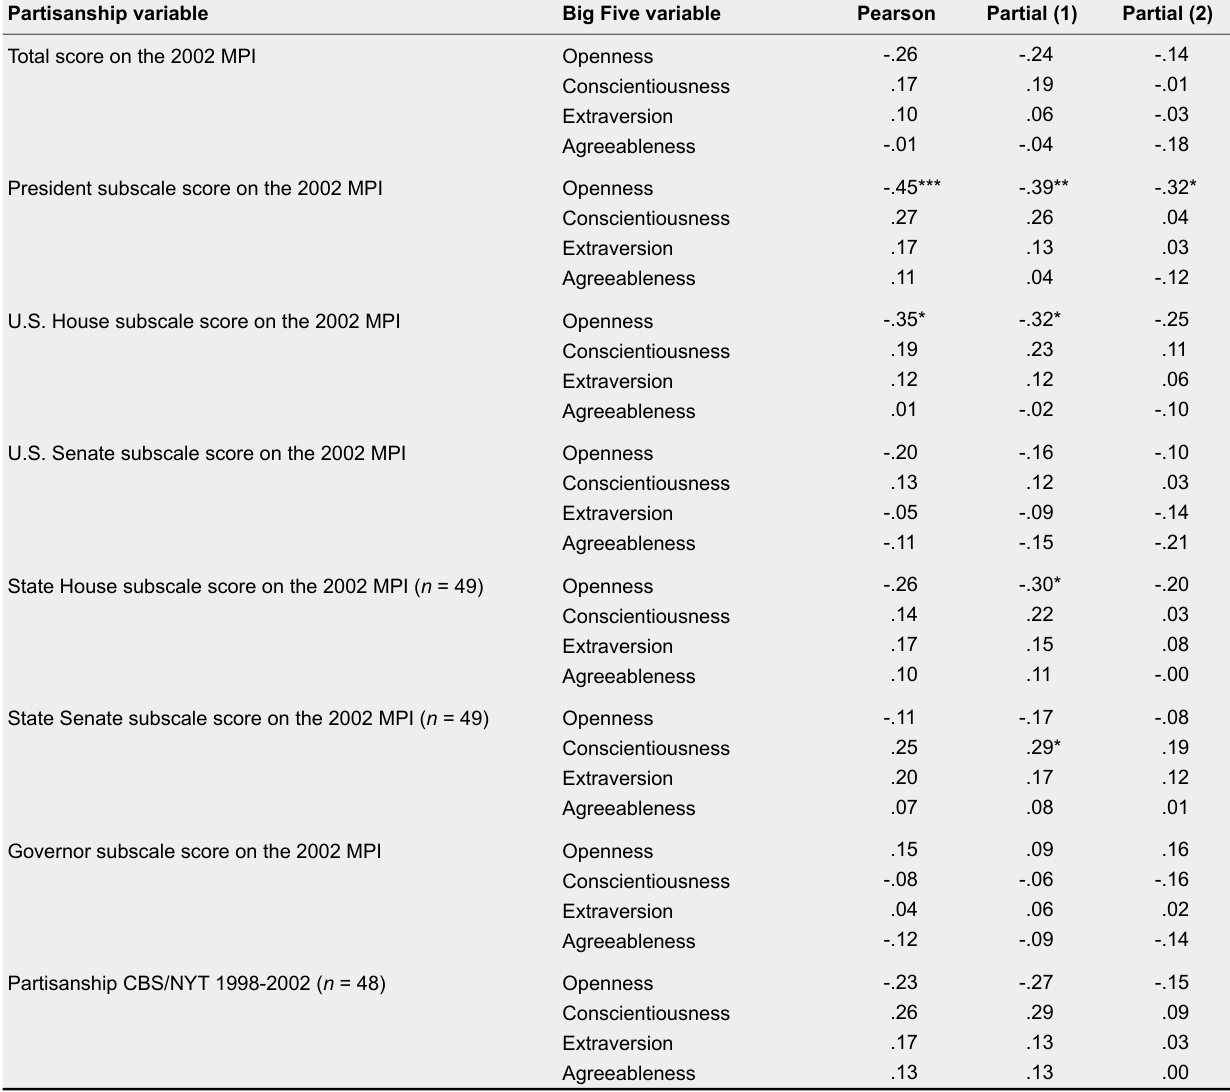
Partial (2)Partial (1)PearsonBig Five variablePartisanship